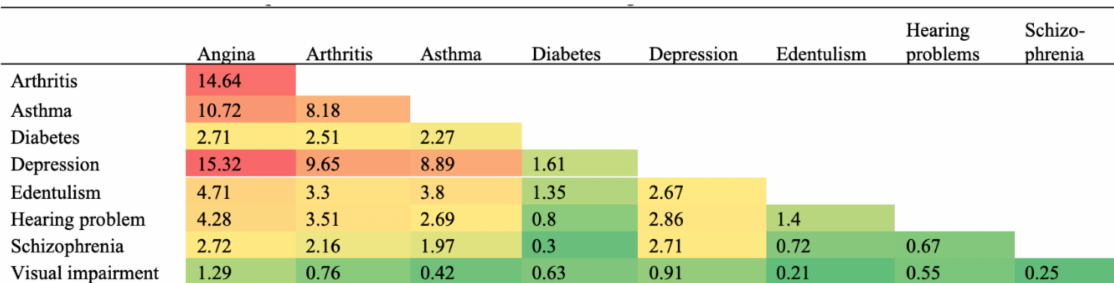
Figure 3. Prevalence of each pair of non-communicable diseases among individuals with tuberculosis. Numbers are presented as